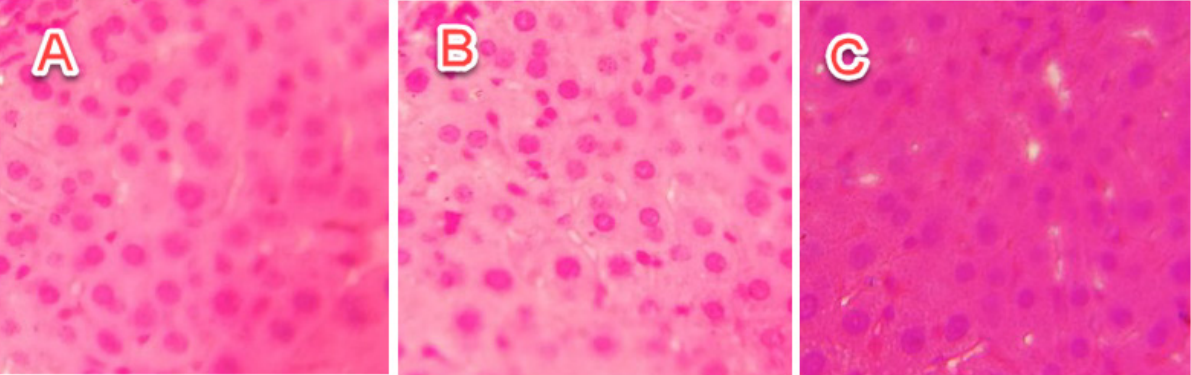
Figure 6 : Histologic section of liver tissue of the control mice. (Section stained with H&E x40). A, B, and C are sections of liver tissue of three mice taken from the control group.